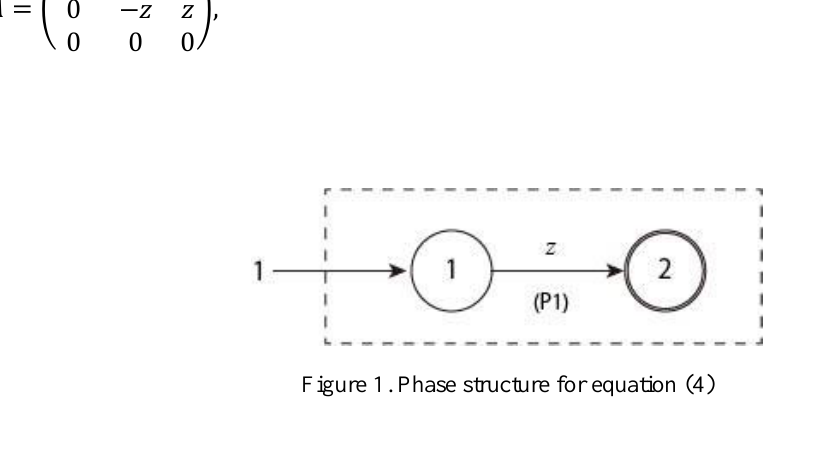
Figure 1. Phase structure for equation (4)